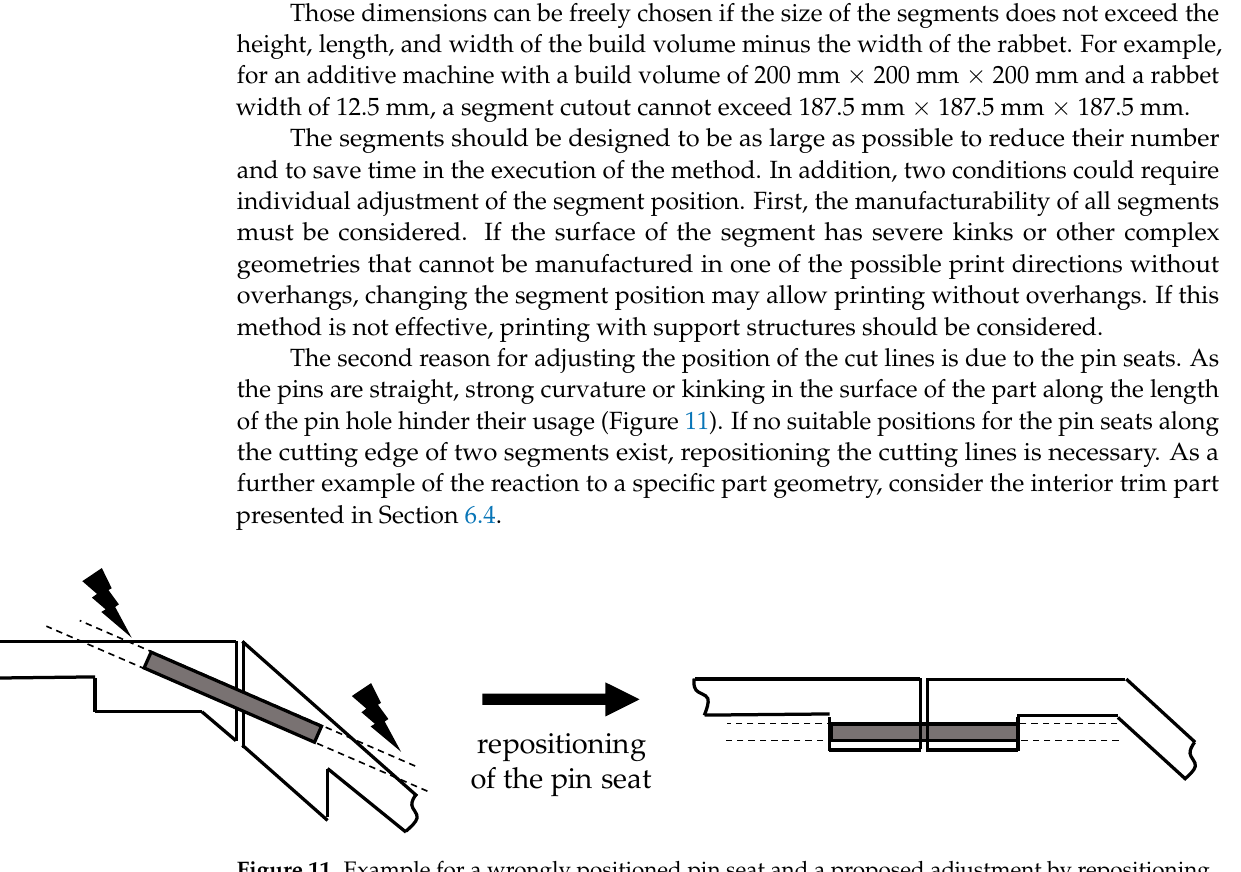
Figure 11. Example for a wrongly positioned pin seat and a proposed adjustment by repositioning. Once the cut lines are finalized, they are extruded in the Z-direction. This creates the planes to cut out the individual segments (Figure 11). The cutting planes are named in alphabetical order in the X-direction and in ascending numerical order in the